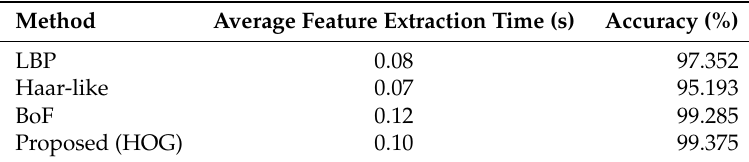
Table 5. Performance comparison with different feature extraction methods.